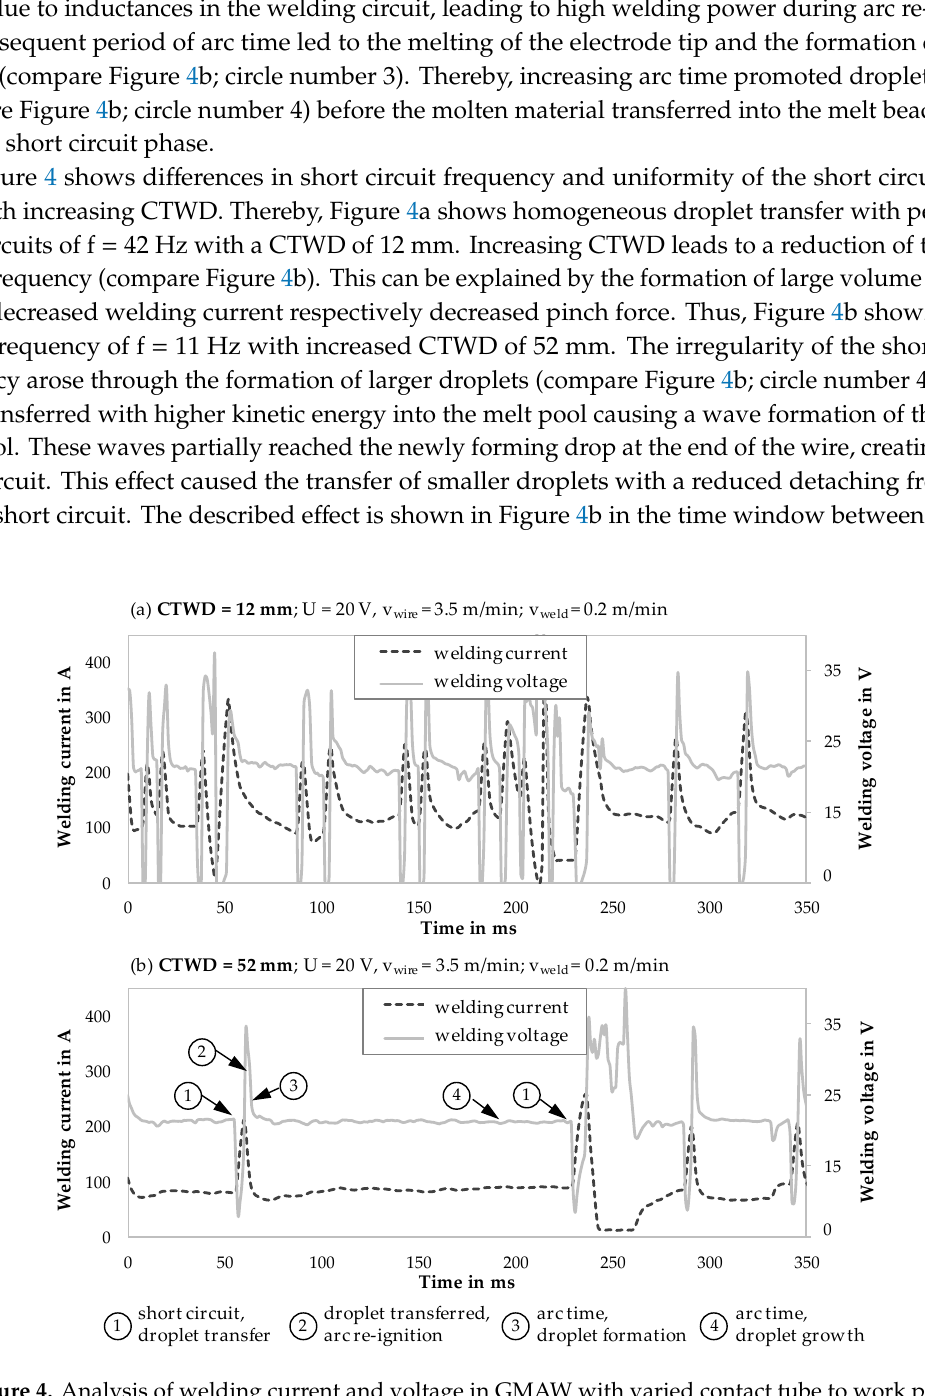
Figure 4. Analysis of welding current and voltage in GMAW with varied contact tube to work piece distance (CTWD); ( a ) CTWD = 12 mm and ( b ) CTWD = 52 mm.